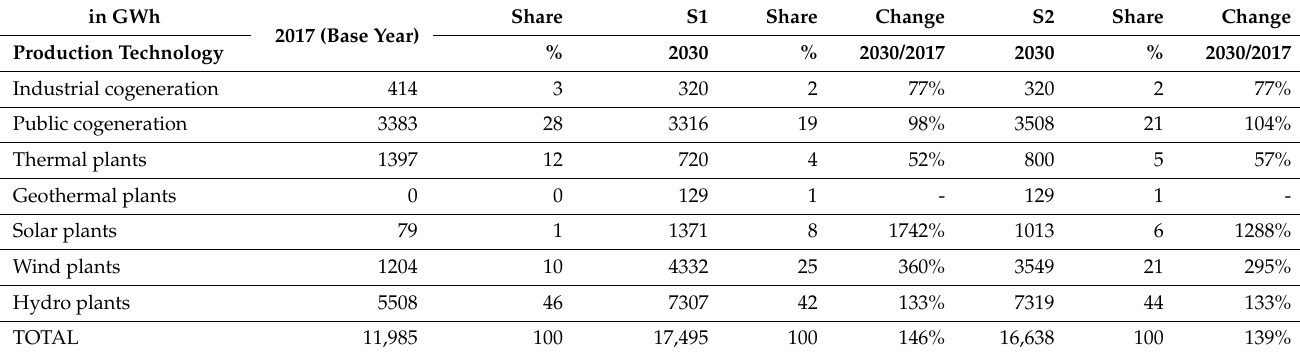
Table 1. Expected electricity production and its structure according to the production technology for S1 and S2 scenarios. in GWh